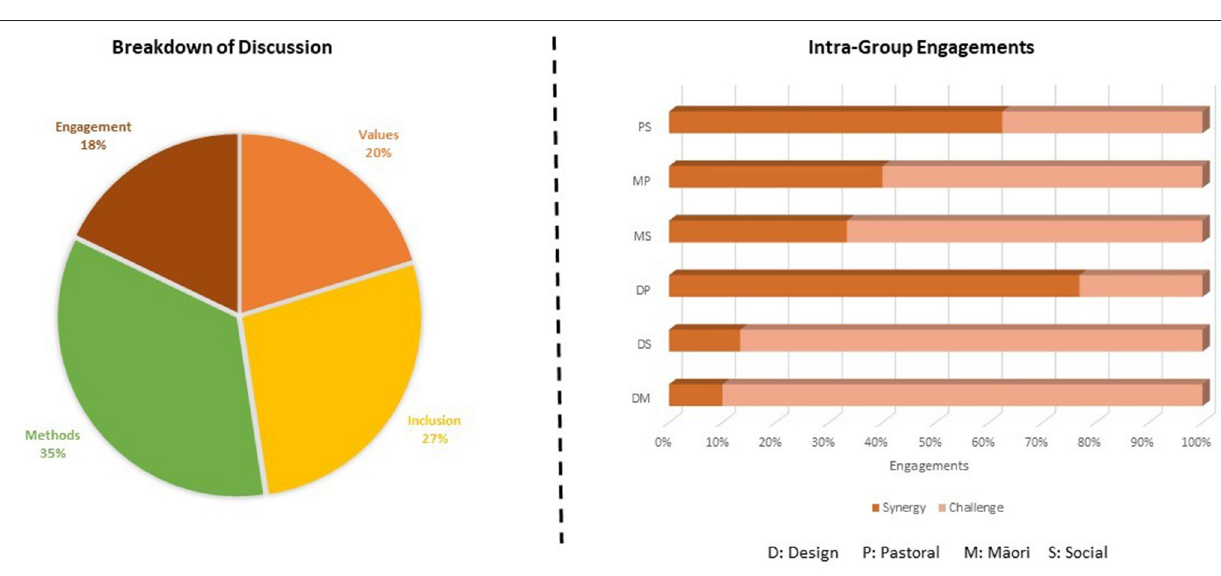
FIGURE 3 | Stage 1 of Co-Design Meetings (The Intra-Group engagements graph only represents coupled engagements such as DM or PS. However, there were many multiple team engagements, such as DMS or SMP. These are currently being analyzed and will be used in future